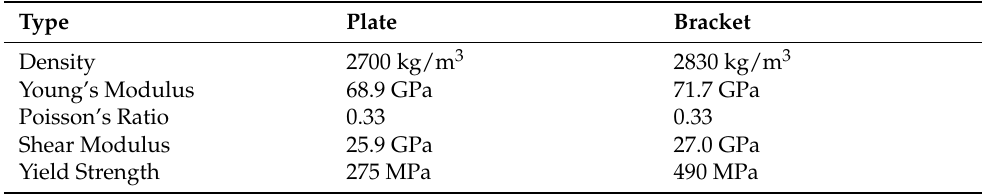
Table 1. Mechanical properties of the